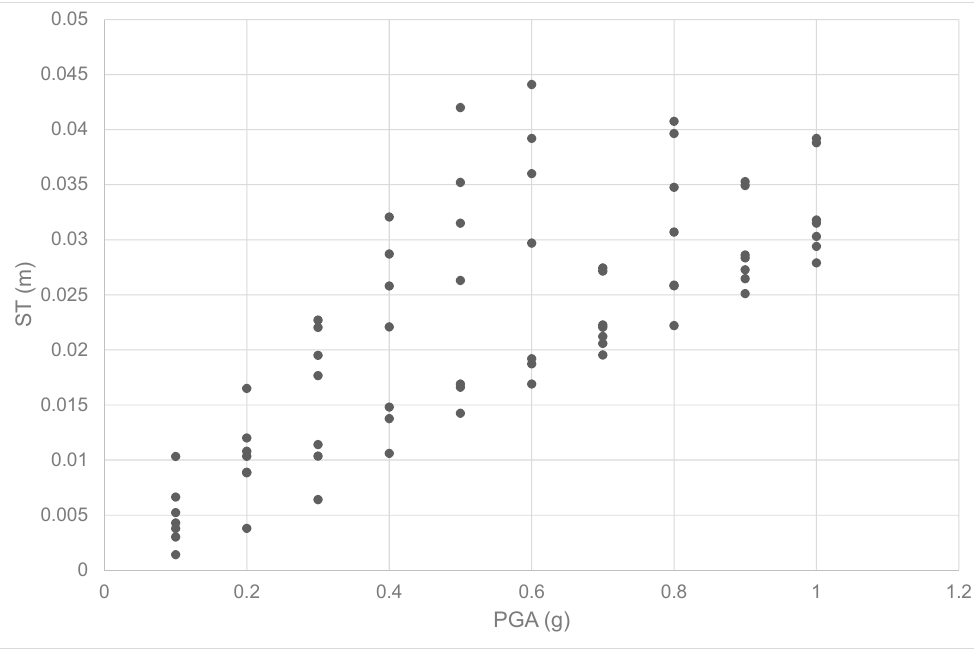
Figure 12. SSI: relationships between PGA (g) and ST (m). Table 9. Soil–structure interaction (SSI): lognormal parameters.